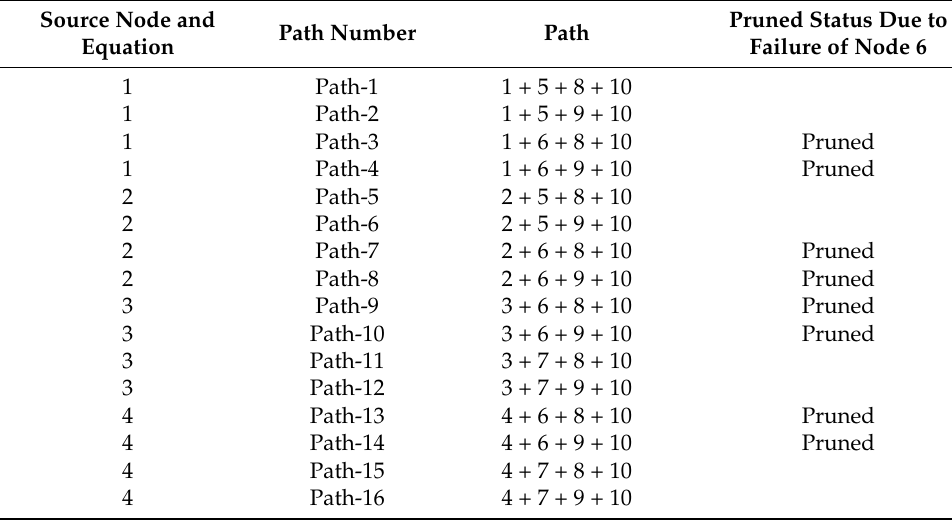
Table 2. Enumerated paths commencing from all source nodes.